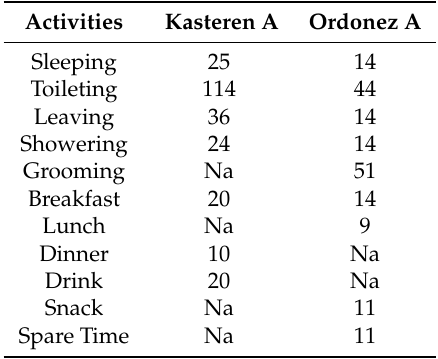
Table 5. Activity instances in the Kasteren and Ordonez